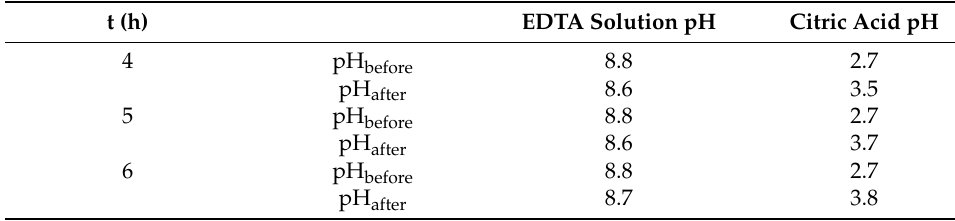
Table 3. Data for pH measurements in solutions.